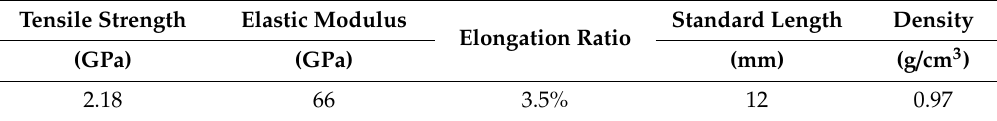
Table 4. Basic physical parameters of PE fiber.